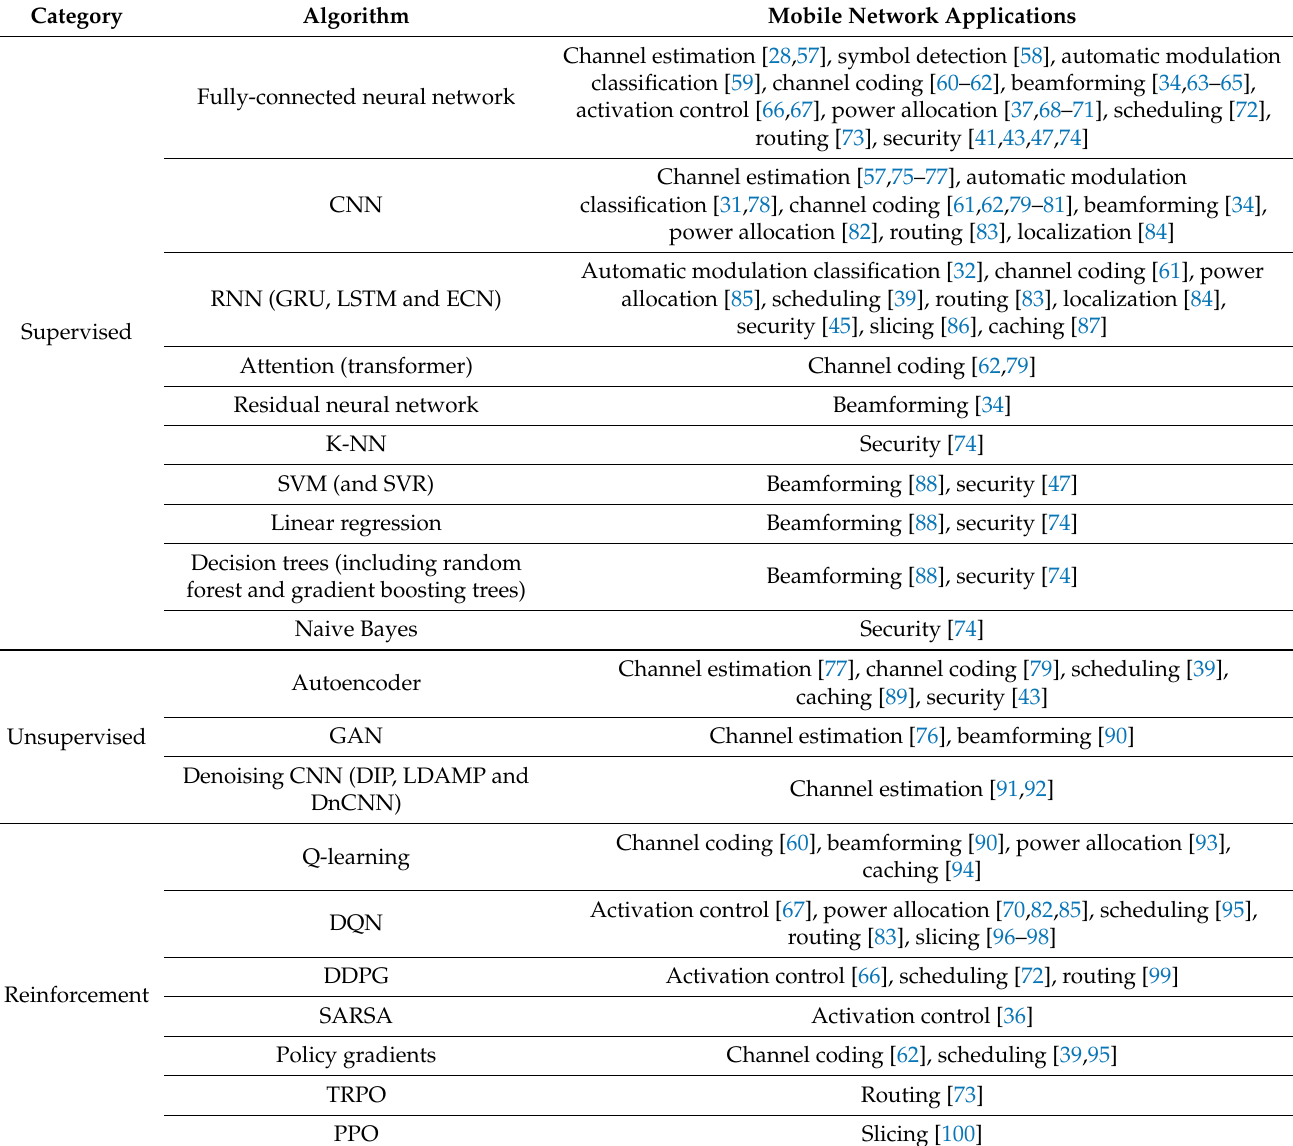
Table 2. AI/ML algorithms used by researchers in the mobile networking